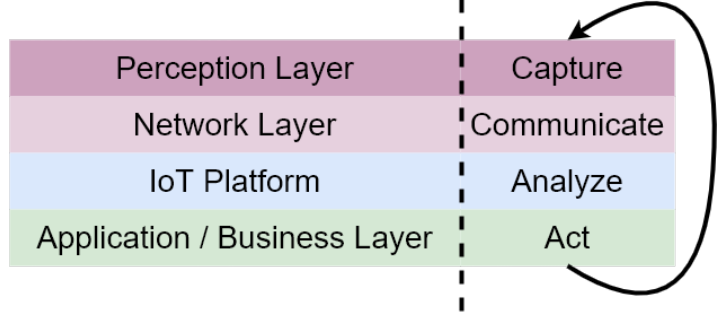
Figure 2. An IoT generic architecture